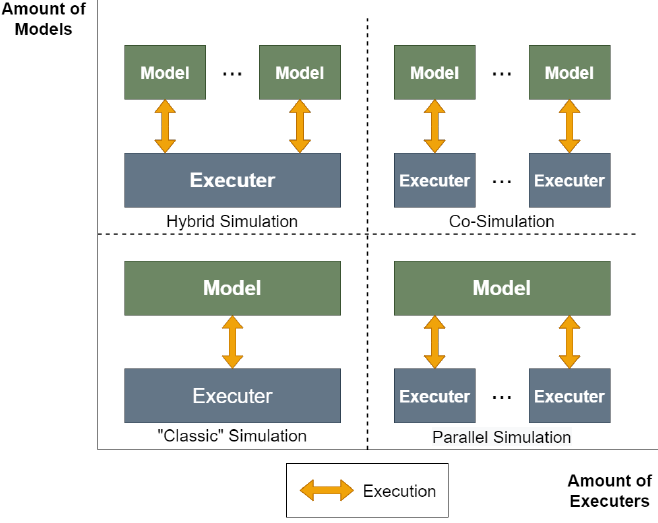
Figure 5. Classification of simulation types (Adapted from Steinbrink et al. [132]).